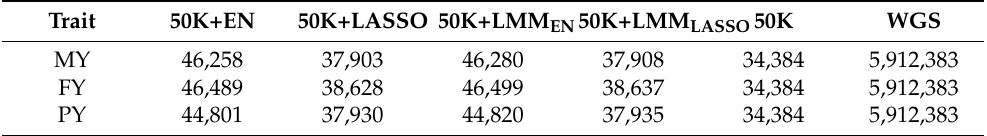
Table 4. The number of SNPs used in different scenarios.